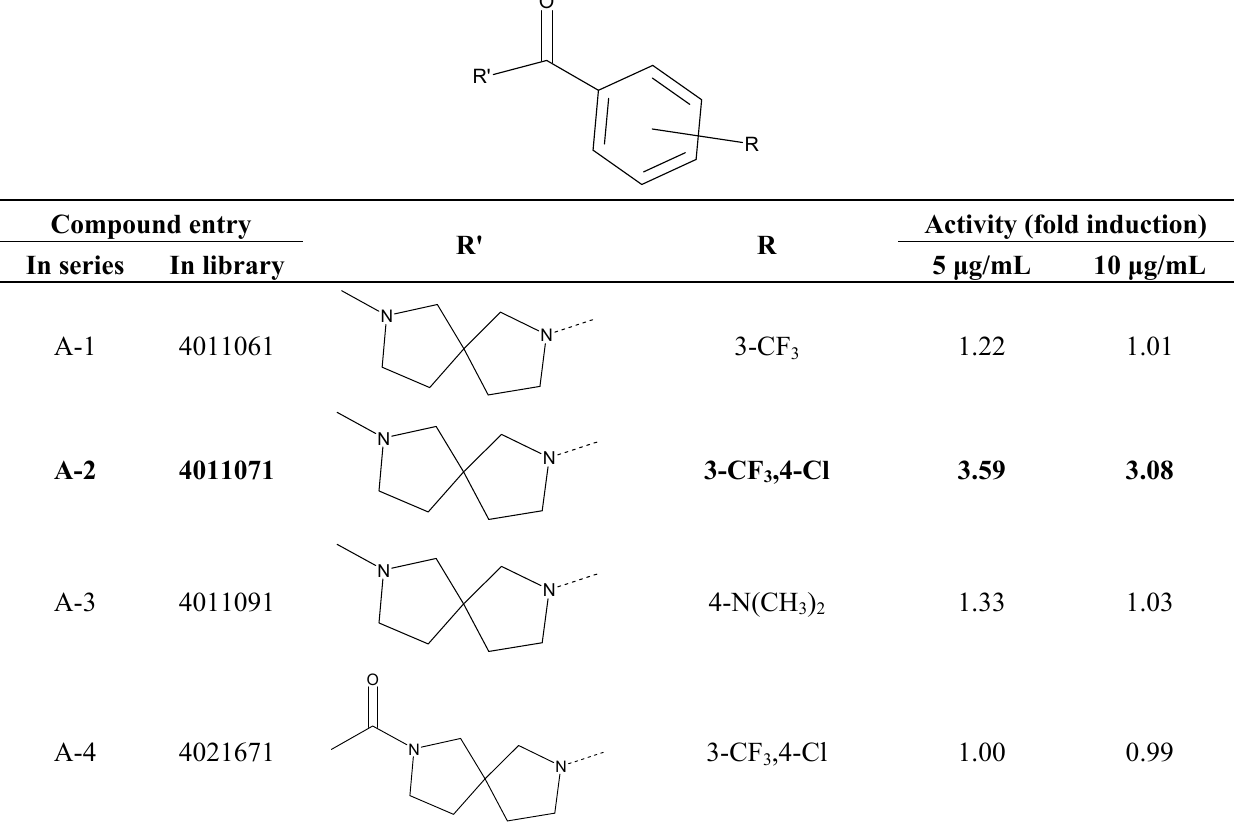
Table 1. Induction of Apo A-I transcription in HepG2 cells.